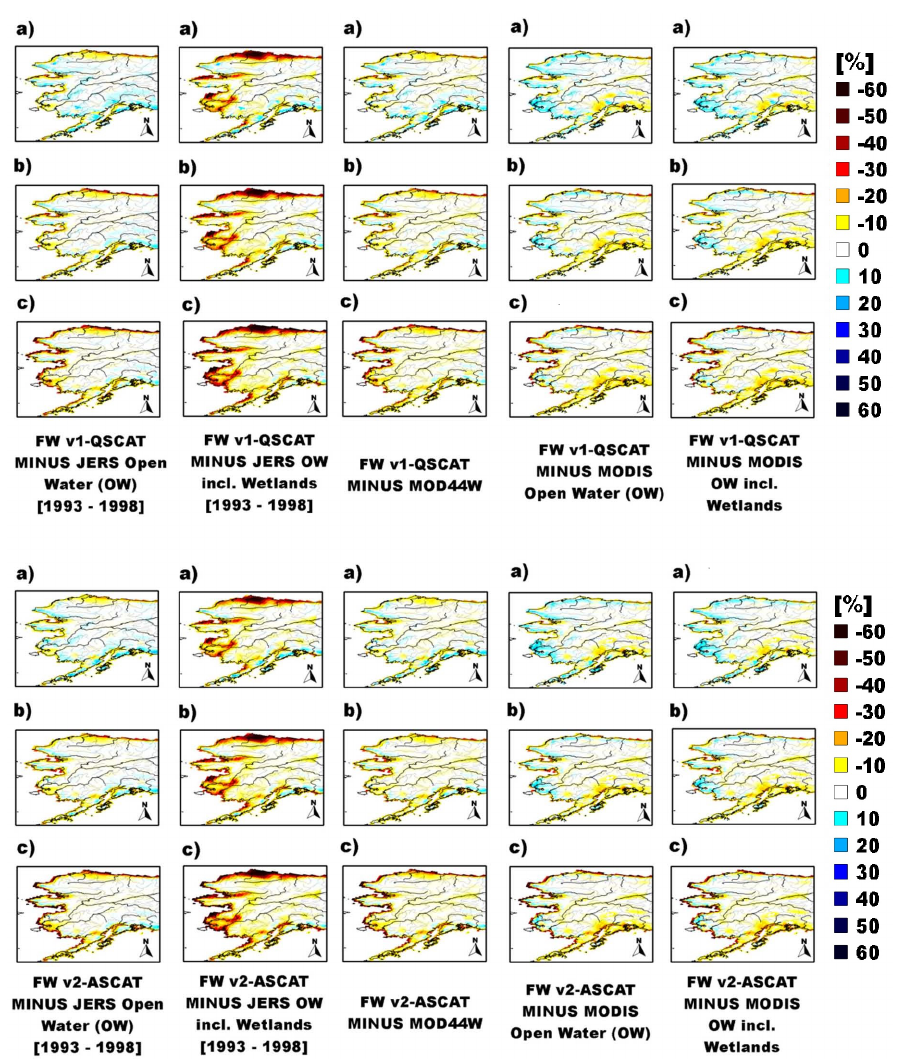
Figure 9. Difference maps between fractional water (FW) from v1-QSCAT (2000–2008) and v2-ASCAT (2009–2012) generated from ( a ) average annual maximum (FW max ); ( b ) mean (FW ave ); and ( c ) minimum (FW min ) minus open water (OW) and wetlands derived from the L-band Japanese Earth Resources Satellite (JERS)-based Alaska wetland map and subsets of static FW from the MOD44W and MODIS including wetlands products over the state of Alaska (54 ˝ N–72 ˝ N, 143 ˝ W–170 ˝ W). Actual figure color is a linear interpolation of the colors in the legend. Map projection same as Figure 2. Distance covered by one degree of latitude is approximately